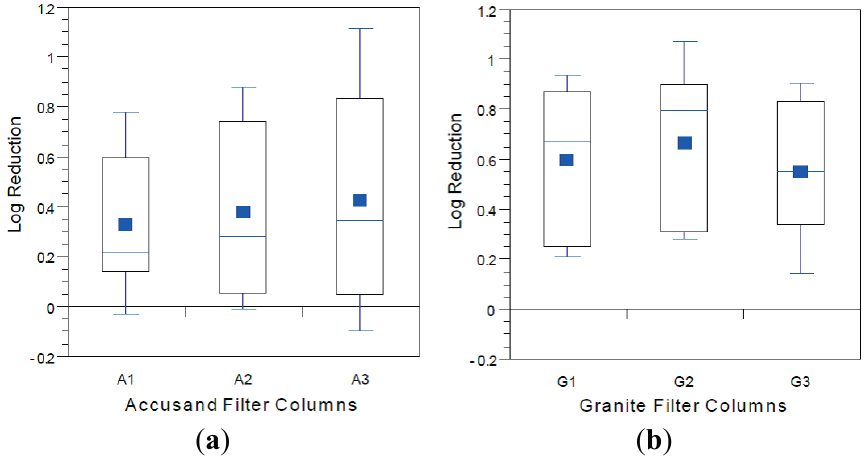
Figure 9. MS2 reductions for ( a ) Accusand media columns; and ( b ) granite media columns in Column Test No. 1 for samples collected throughout the eight-week experiment. N = 7 for G3; 8 for A1; 9 for G1, G2, A2 and A3.